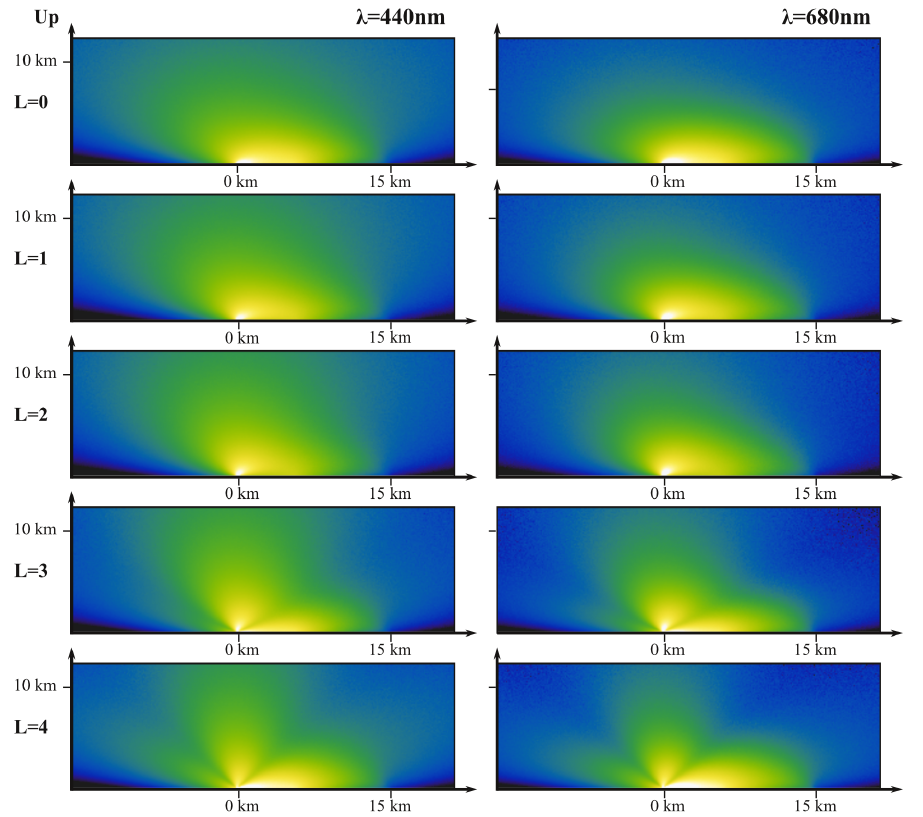
Figure 6. Section of the scattering density distribution for different combinations of AOD and wavelength.(in the figure: the source is at 0 km, and the observer is at 15 km). The results depend on many parameters, like aerosol optical depth (AOD), density profile,